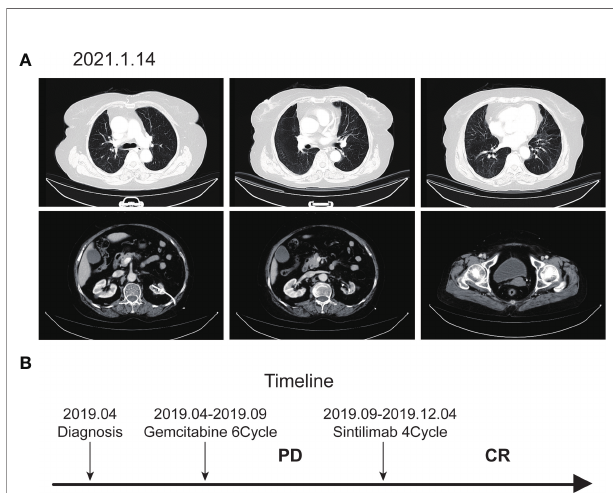
FIGURE 5 | Imaging after discontinuation of Sintilimab for eight months. (A) The in fl ammation in both lungs disappeared, the metastases in both lungs disappeared, and the soft tissue shadow at the entrance of the ureter on the left side of the bladder disappeared. (B) Timeline of disease status and corresponding treatment